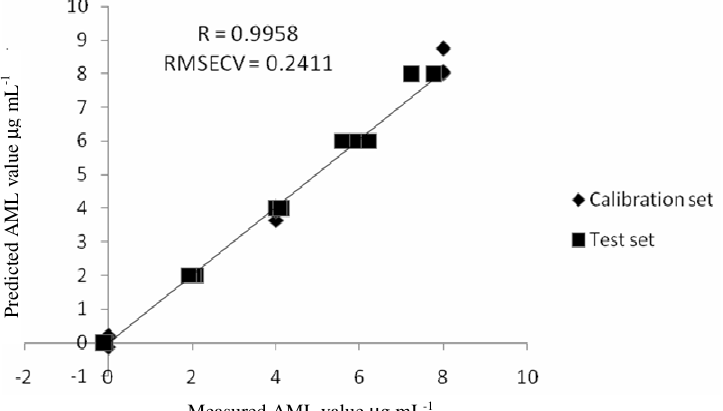
Figure 5. Predicted values versus measured AML values for siPLS model, using intervals 3